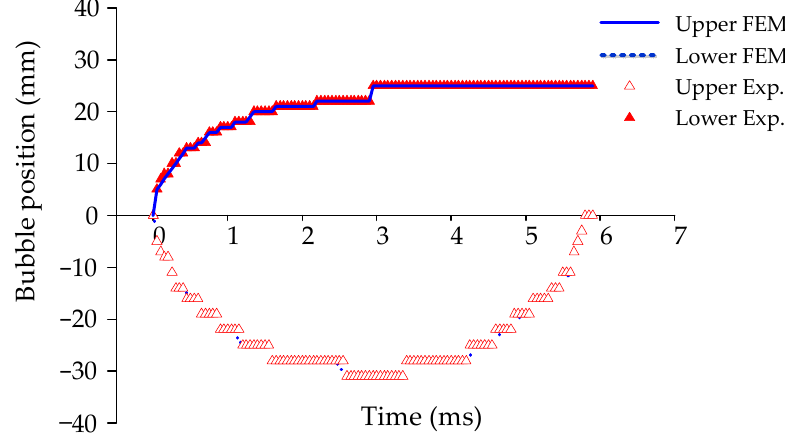
Figure 19. The position of the upper bubble surface and the lower bubble surface.